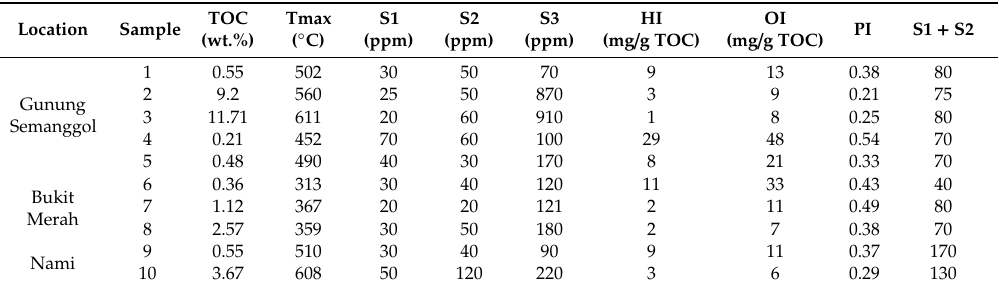
Table 2. TOC (wt.%) content along with Rock-Eval pyrolysis of black shale from the Semanggol Formation.